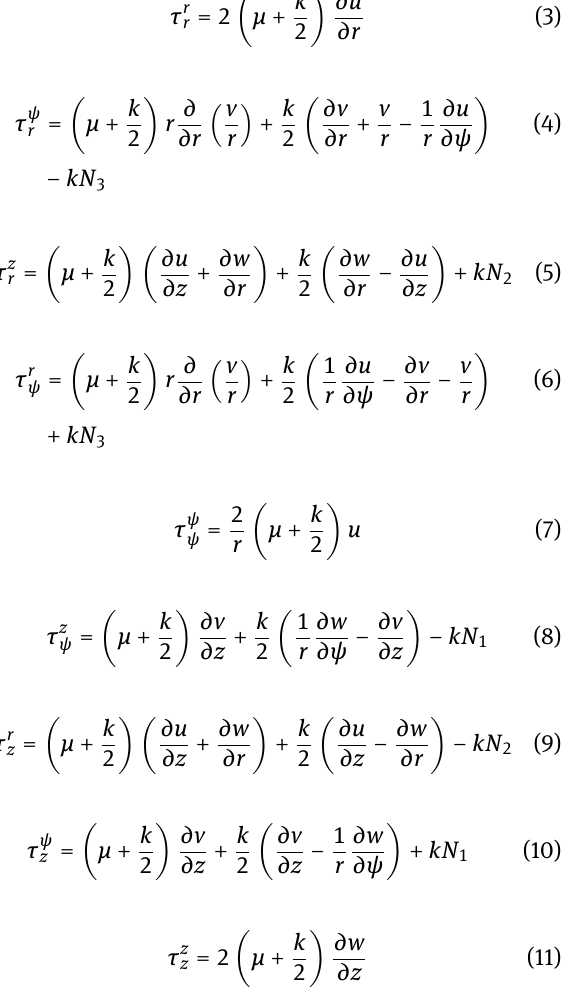
Figure 1: Geometrical configuration of the